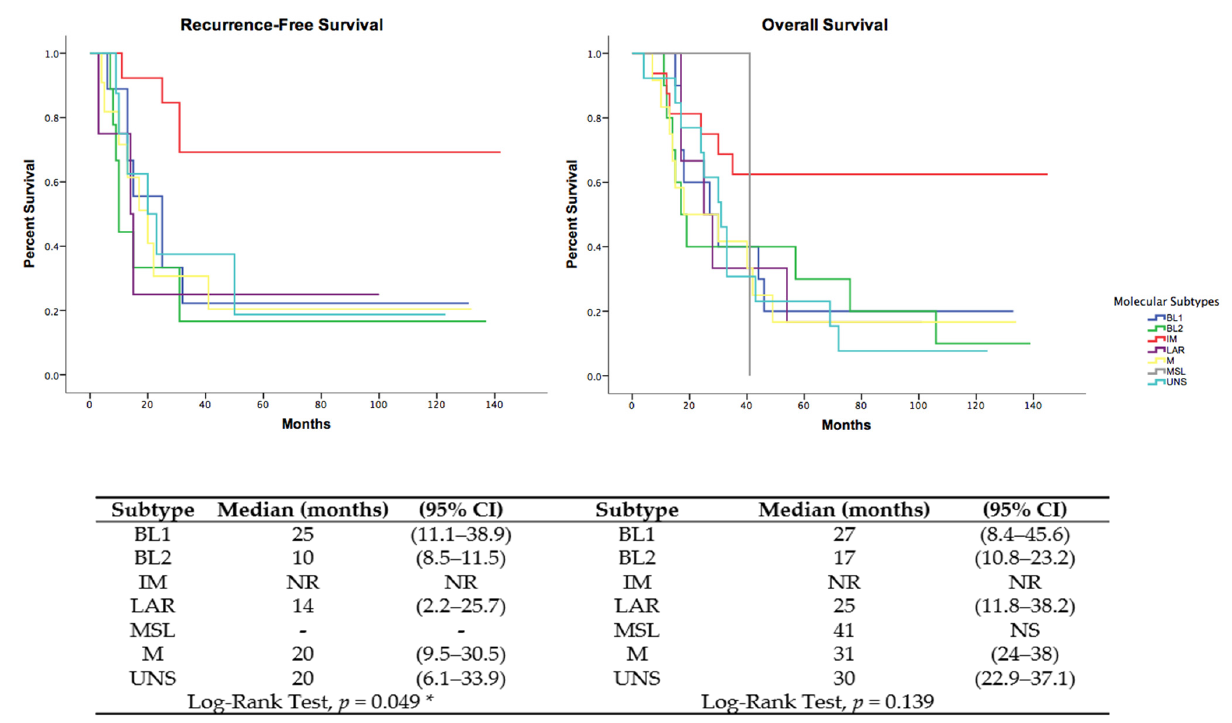
Figure 6. Kaplan–Meier curves for recurrence-free survival in patients with stage III disease ( left ) and overall survival ( right ) for all samples classified with different molecular TNBC subtypes. * p < 0.05. CI: confidence interval; BL1 basal like 1; BL2: basal like 2; IM: immunomodulatory; MSL: mesenchymal stem-like; M: mesenchymal; NR: not reached; NS: